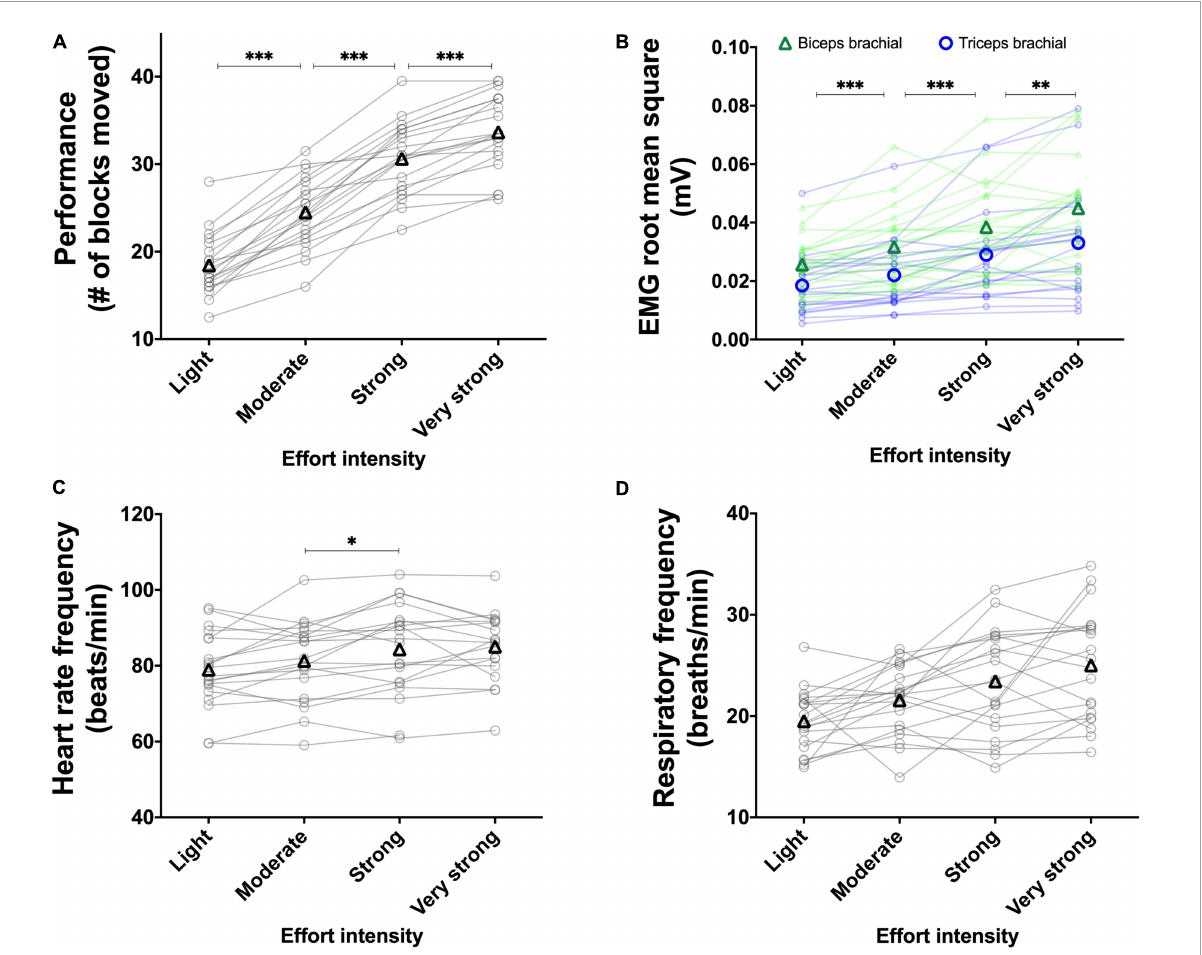
FIGURE3 Experiment 1A: Using the perception of effort to prescribe the exercise during the box and block test. Effect of increasing the prescribed effort intensity on performance ( A , n = 20), EMG root mean square of the biceps (green line) and triceps (blue line) brachial muscles ( B , n = 19), heart rate frequency ( C , n = 18), and respiratory frequency ( D , n = 20) during the box and block test. The exercise was prescribed at four intensities of perceived effort via the CR100 scale: light (13/100), moderate (23/100), strong (50/100), and very strong (70/100). Data are presented as the main effect of effort intensity (A, C, D) and effort intensity × muscle interaction (B) . The n indicates the number of participants with all the data in each four effort intensities. Changes in the n reflect data loss due to the issue with equipment or movement artifact. Individual data are presented in light markers and means in dark markers. *Main effect of intensity, the difference between two effort intensities. * p < 0.05, ** p < 0.01, and *** p <